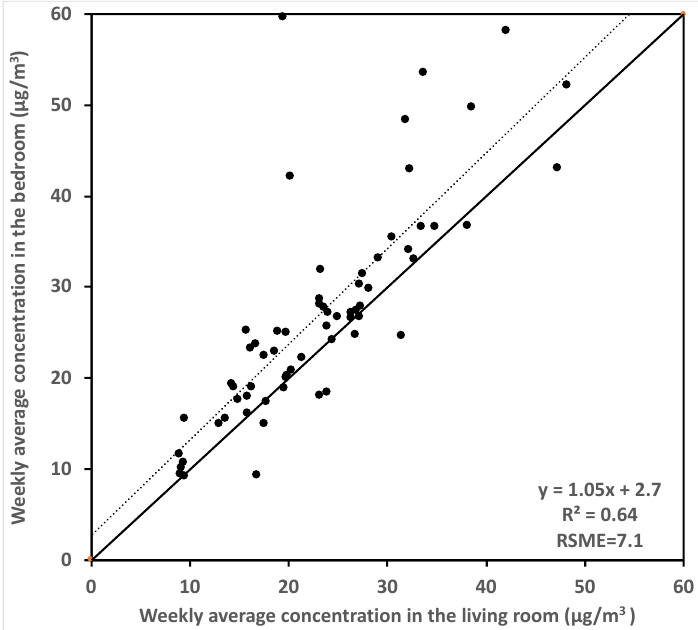
Figure 2. Weekly averaged formaldehyde concentrations measured in the master bedroom and living room in 63 test houses with both locations measured.